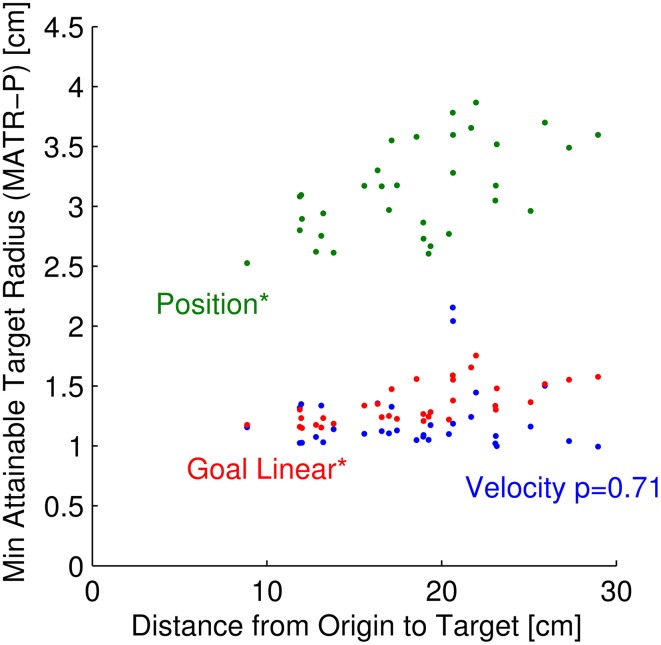
Minimum attainable target size vs. distance from origin to target. For each of 33 targets, the relationship between minimum attainable target radius, averaged across neuron parameter sets (MATR-P) is plotted against the distance from origin to target. The green dots represent this relationship for 50 position neurons. The blue and red points represent this relationship for 50 velocity and 50 linear goal neurons, respectively. The relationship between MATR-P and distance from target to origin is statistically significant for position and linear goal neurons (p < 0.001, labeled above as *), but is not significant for velocity neurons (p = 0.71).